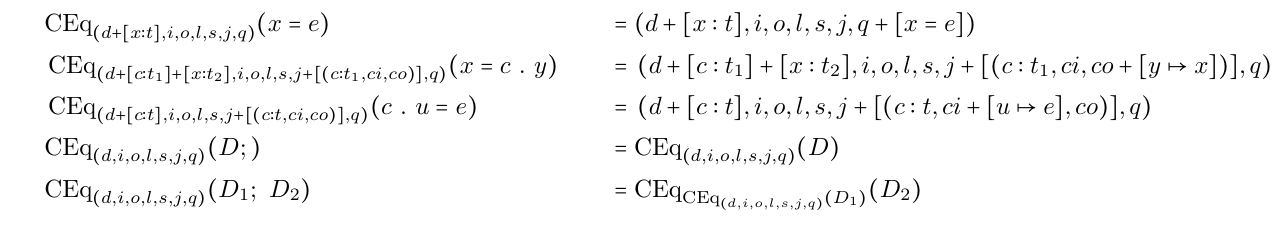
Figure 5: Function CEq—Create auxiliary structure for equation